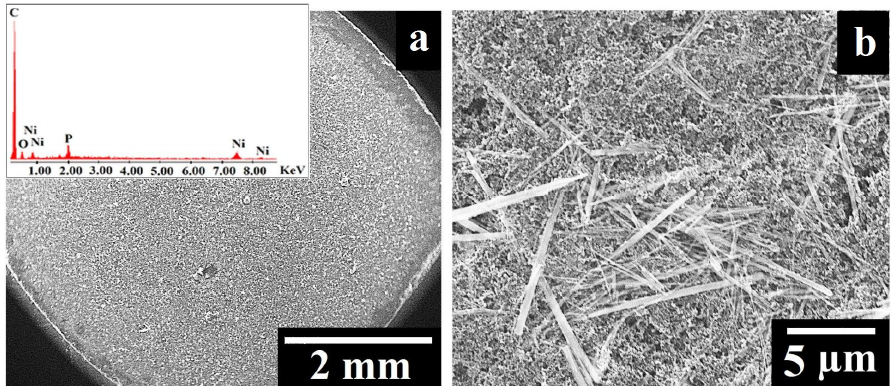
Figure 2. ( a ) SEM image recorded on the surface of the G9 electrode at low magnification. Inset: EDX spectrum of the G9 electrode. ( b ) SEM image recorded on the surface of the G9 electrode at high magnification.